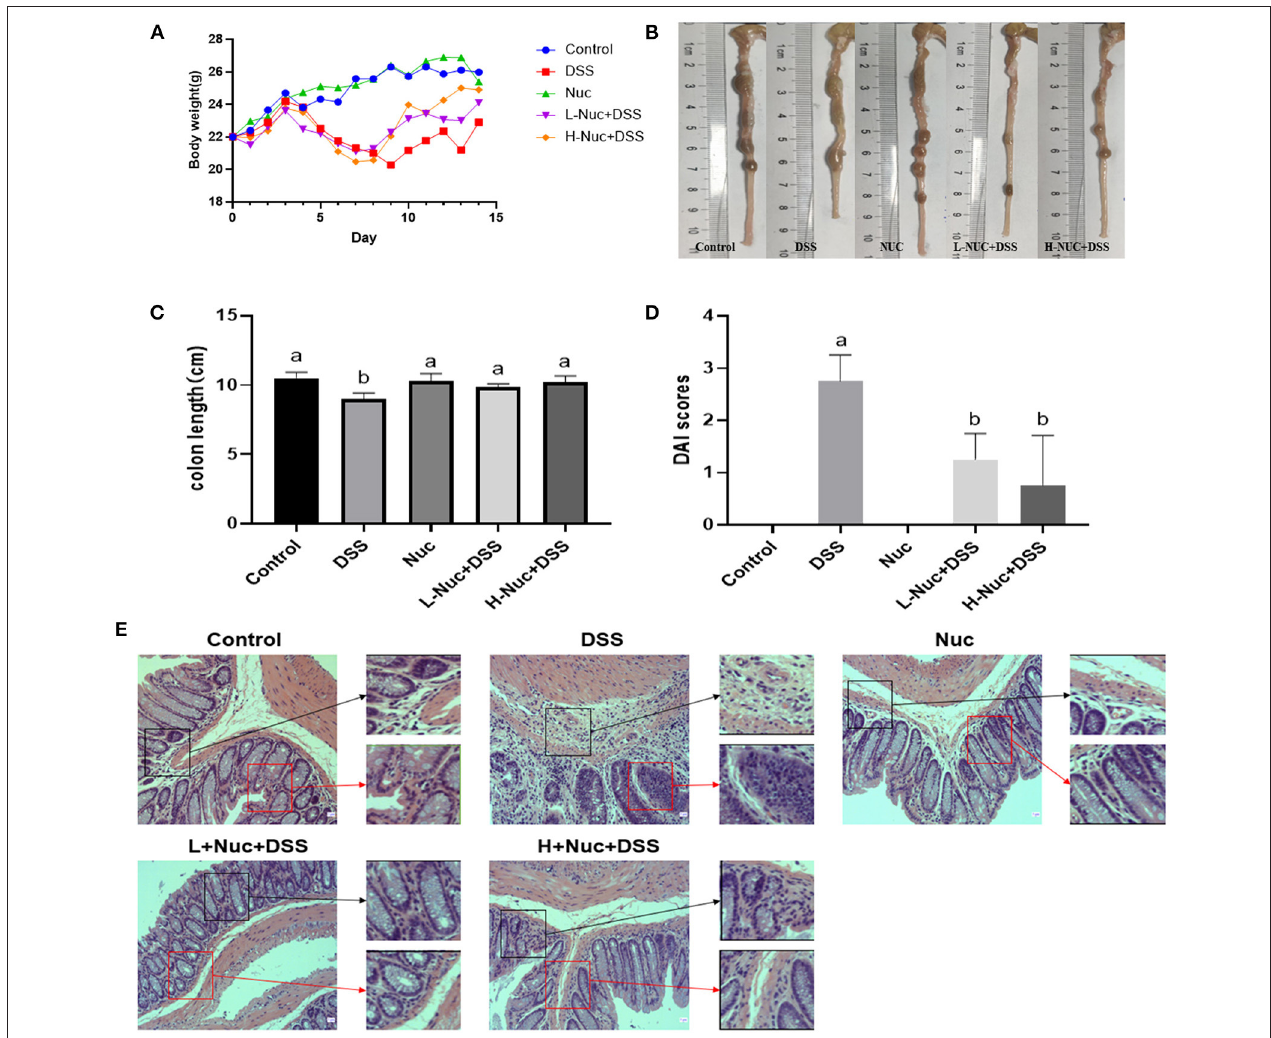
FIGURE 1 | Nuciferine reduced clinical signs in DSS-activated colitis ( n = 6). (A) The illustrative images of colon samples (B) Average body weight (C) Average colon length and (D) Disease activity index score. (E) H&E staining of the distal colon tissues The dataare expressed as the mean ± S.D. Significant differences were considered at P < 0.05. a,b Bars without the same superscripts differ significantly ( P <